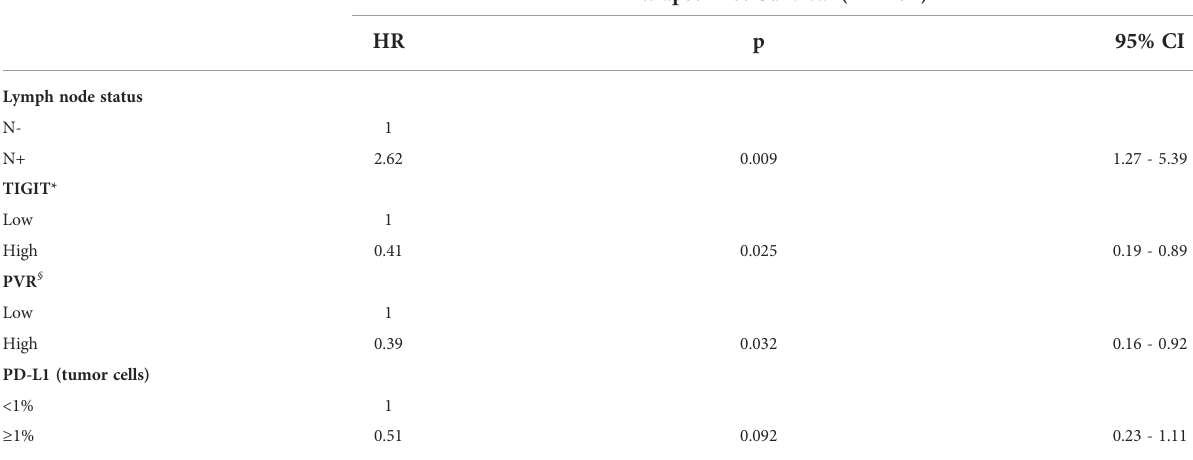
TABLE 5 Multivariate analysis of clinicopathological variables associated with relapse-free survival in the non-molecular apocrine TNBC